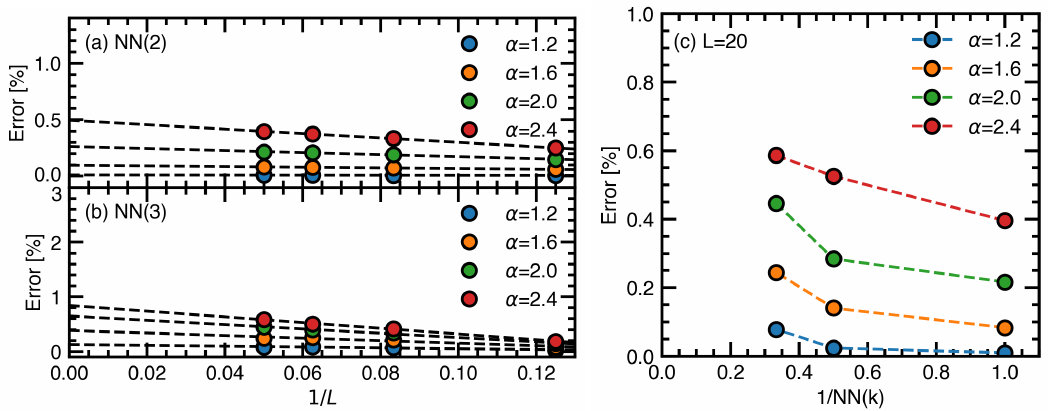
Figure 12: Relative error (in percentage) as a function of 1 / L on the parent Hamilto- nian constructed from the NN ( 2 ) basis (panel (a)) and from the NN ( 3 ) basis (panel (b)). The figure shows a very modest error even in the thermodynamic limit. (c) Relative error (in percentage) as a function of 1 / k , the number of nearest neighbors included in the reconstruction basis. At present we cannot infere a clear thermody- namic behavior for k → ∞ , as the number of points is too modest to fit. Nonetheless, the error seems bounded within